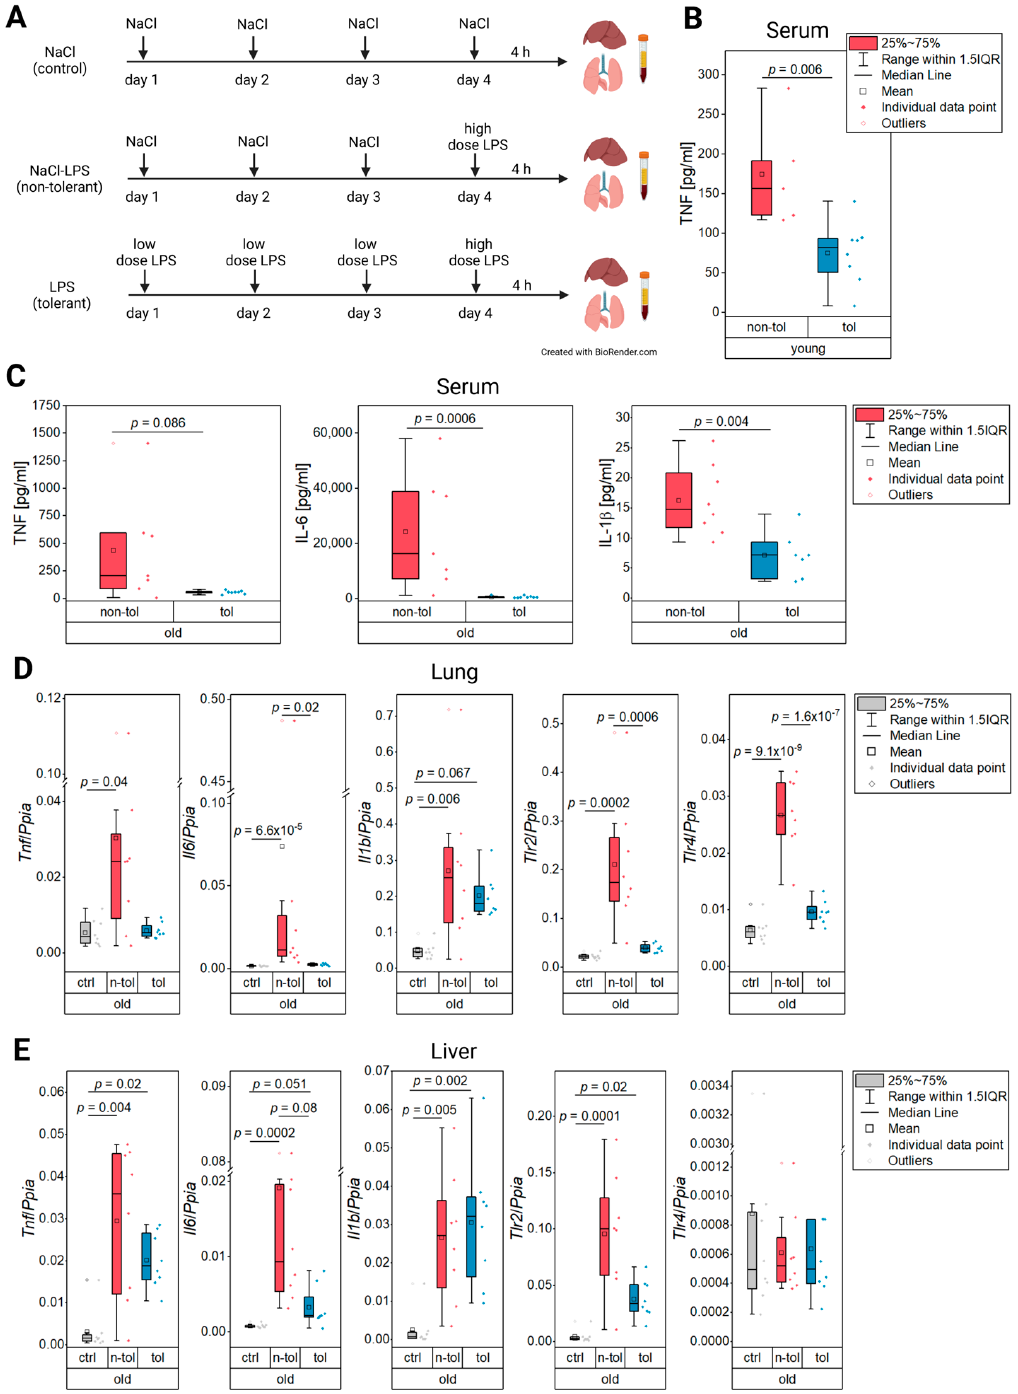
Figure 1. In vivo LPS tolerance model ( A ), protein levels of inflammatory cytokines in serum ( B , C ), and relative gene expression in lung and liver tissue ( D , E ). ( A ) Mice were injected (i.p.) with NaCl (0.9%), a low dose of LPS (0.5 mg/kg body weight), or a high dose of LPS (5 mg/kg body weight) on four consecutive days. Liver, lung, and serum were harvested 4 h after the final injection. ( B ) Protein levels of TNF were determined by ELISA in young non-tolerant and tolerant mice. ( C ) Protein levels of TNF, IL-6, and IL-1 β were determined by ELISA in old non-tolerant and tolerant mice. ( D ) Relative expression of inflammatory markers Tnf, Il6, and Il1b as well as toll-like receptors in lung and ( E ) liver